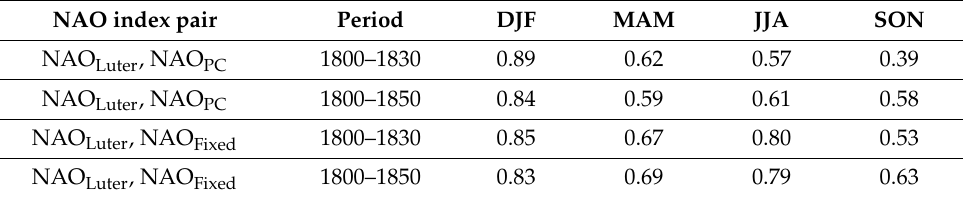
Table 6. Correlation coefficients between our seasonal NAO PC and NAO Fixed indices and Luterbacher et al. (2002) NAO (NAO Luter ) for 1800–1830 and 1800–1850. All values are significant at the p ≤ 0.05 level.